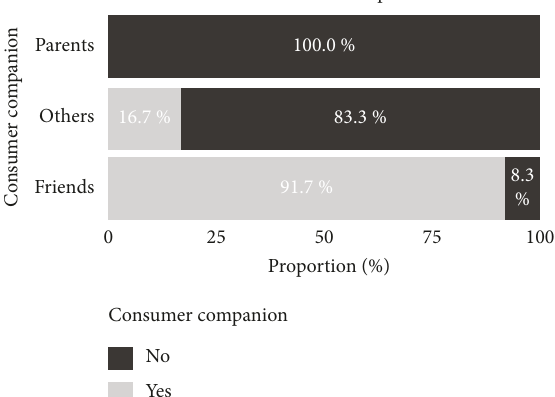
Figure 5: Distribution of patients according to the duration of their treatment.